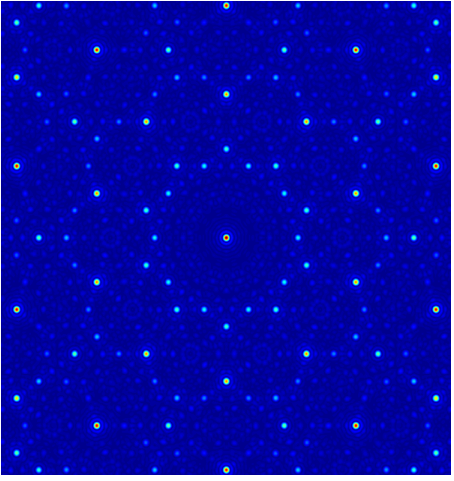
Figure 3. The normalized FT (magnitude) of the Penrose point